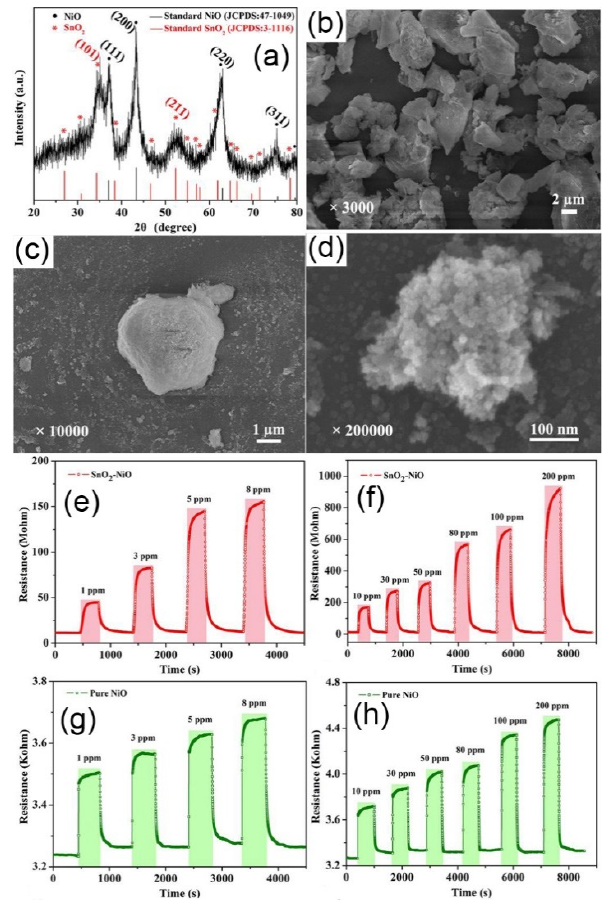
Figure 5. The XRD pattern ( a ) and the SEM images ( b – d ) of SnO 2 nanoparticles-modified NiO nanostructure (p-n junctions), the dynamic sensing performances of the pure NiO and the SnO 2 nanoparticles-modified NiO nanostructures towards 1–200 ppm toluene at 250 °C ( c , e – h ). Copied with permission [91]. Copyright 2018, Elsevier.